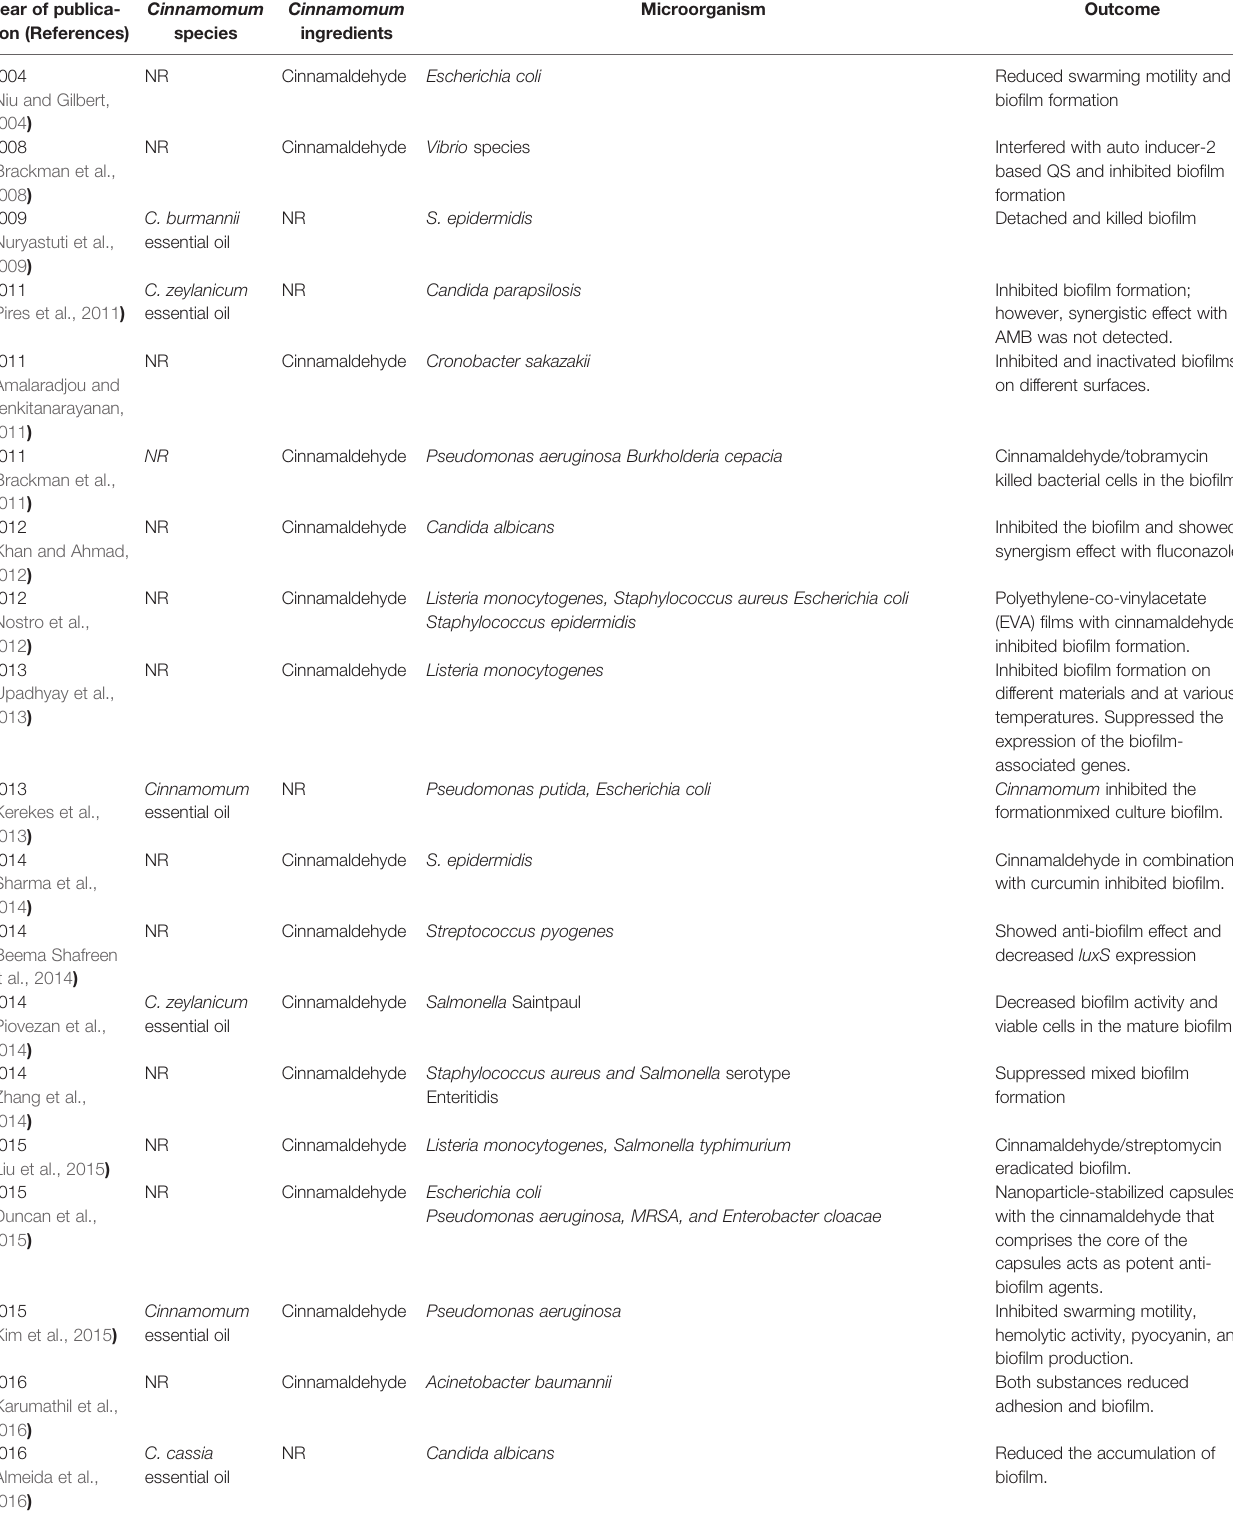
TABLE 1 | Previous studies that evaluated the antibio fi lm effect of Cinnamomum and its active components against different bacterial and fungal bio fi